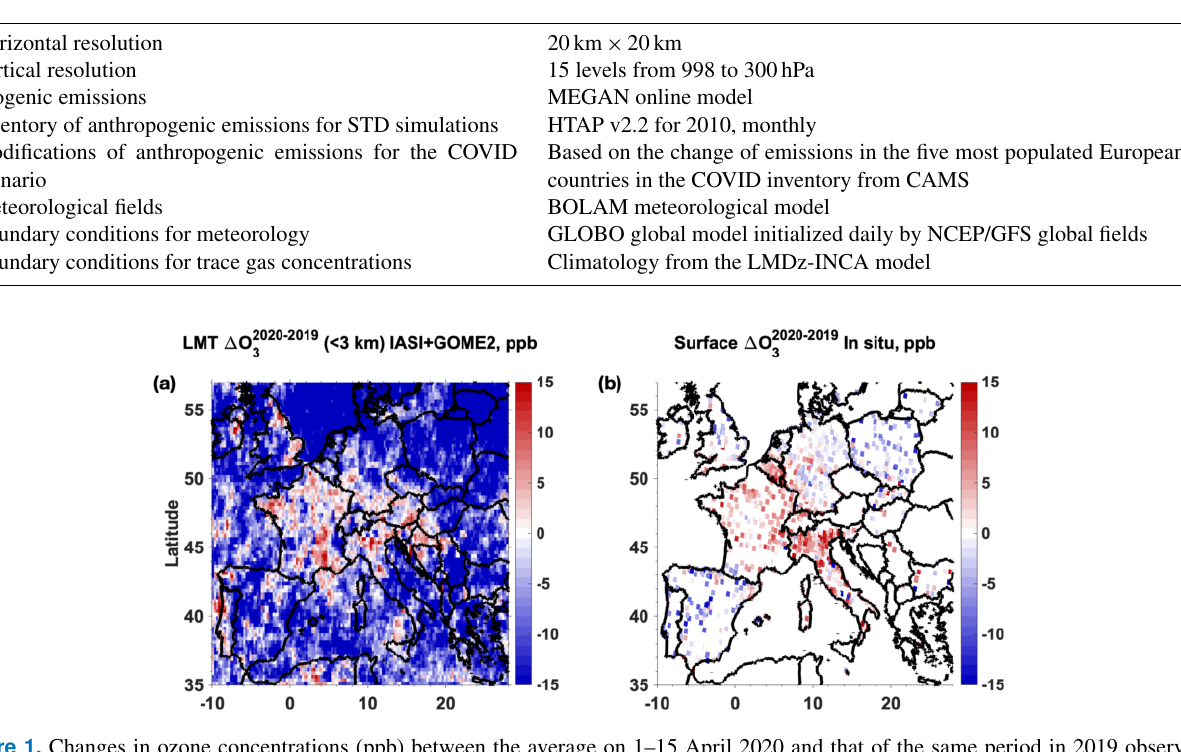
Table 1. Brief description of the setup of the CHIMERE model, used for the simulations of ozone distribution over Europe in April 2019 and April 2020 (STD and COVID scenario).